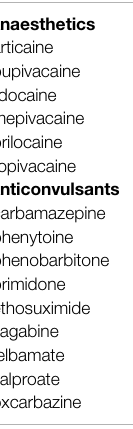
TABLE 2 | Drugs associated with porphyrias.